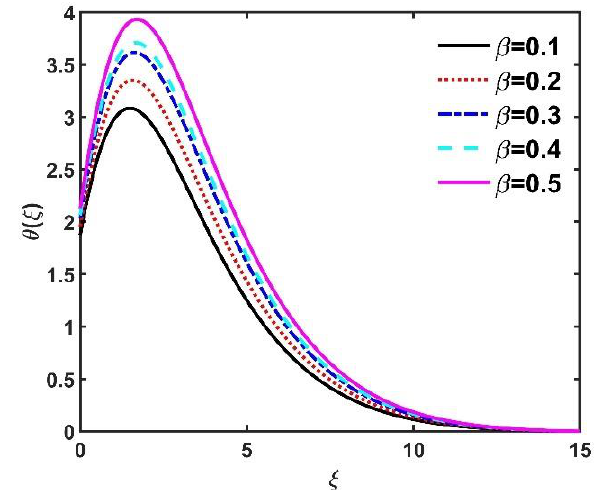
Figure 9. Impact of 𝛽 on 𝜃(𝜉) .